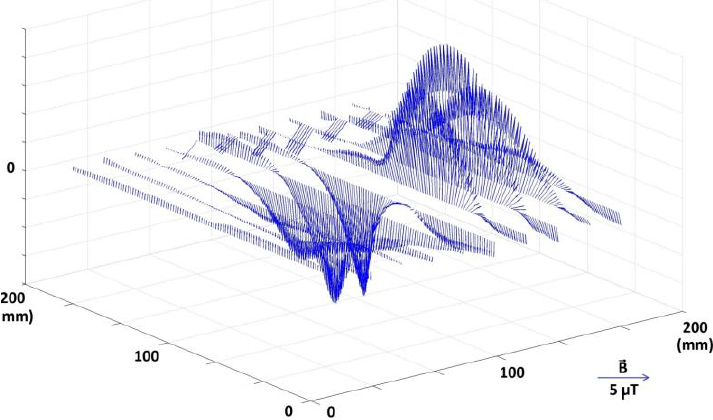
Figure 3. Visualization of induction vectors value and direction on measurement lines for simple dipole sample, with magnetic background removed. Additional disturbances of the magnetic field can be clearly seen.